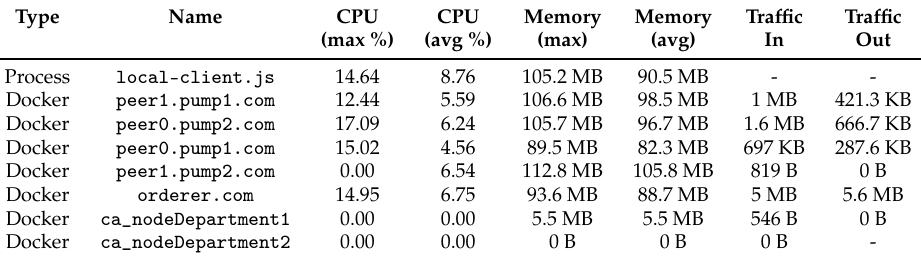
Table 6. Resource Use Analysis of Proposed